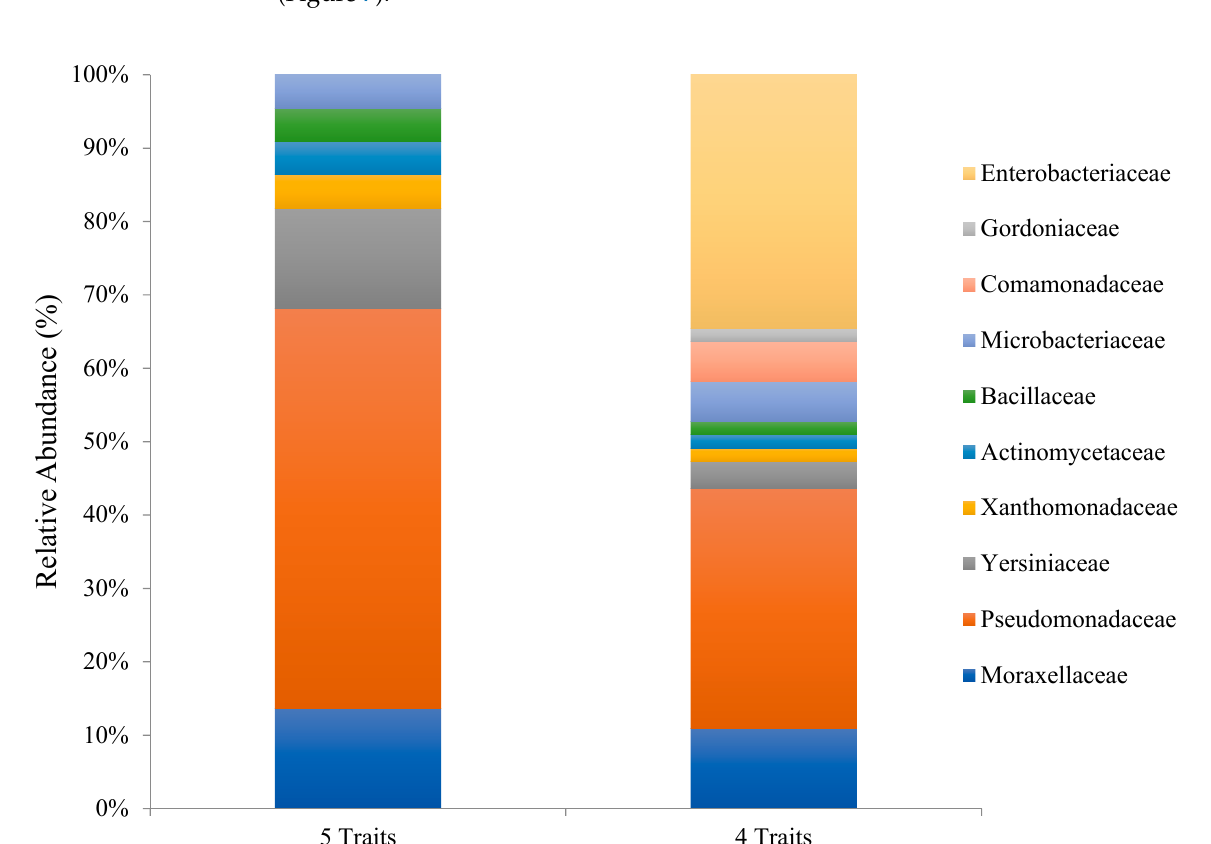
Figure 7. Bars indicate the relative abundance of families among isolates presenting four or five different PGP-associated traits in vitro .